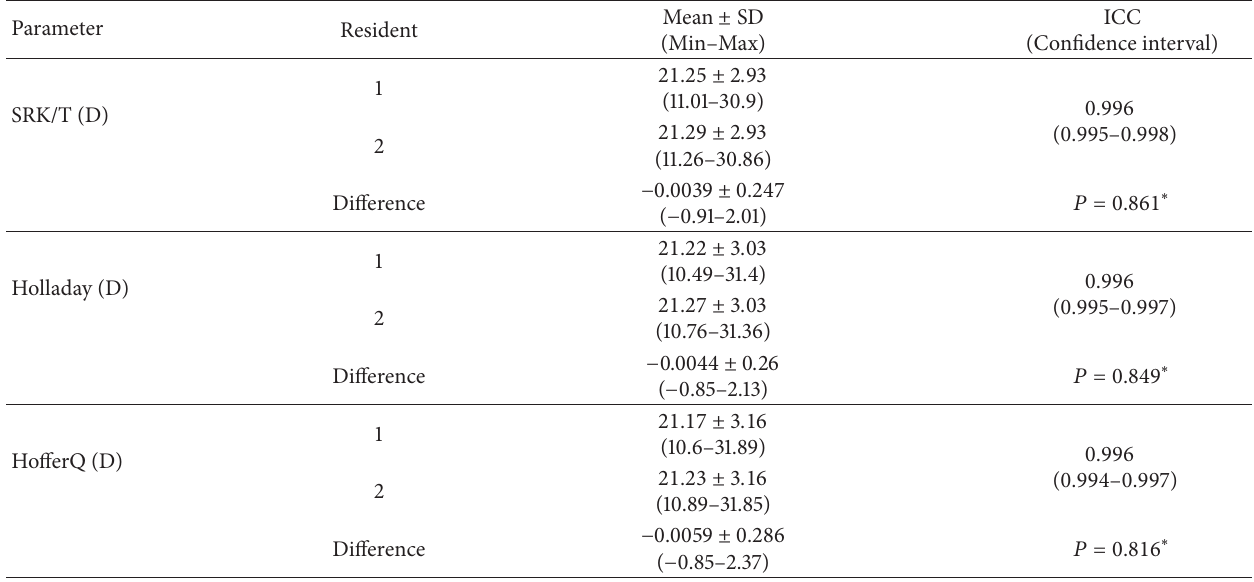
Table 4: Comparison of IOL power measurement means obtained by both ophthalmology residents (Reproducibility).